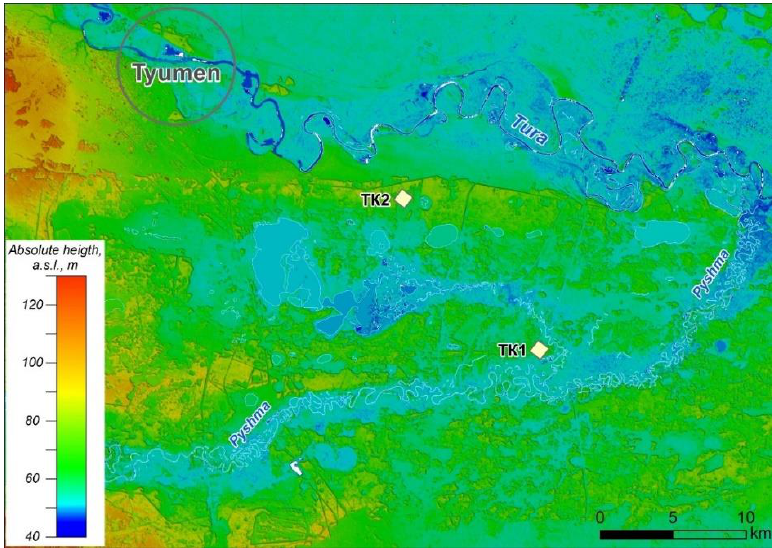
Figure 2. Topographic image of the study area (ALOS Global Digital Surface Model (AW3D30)).